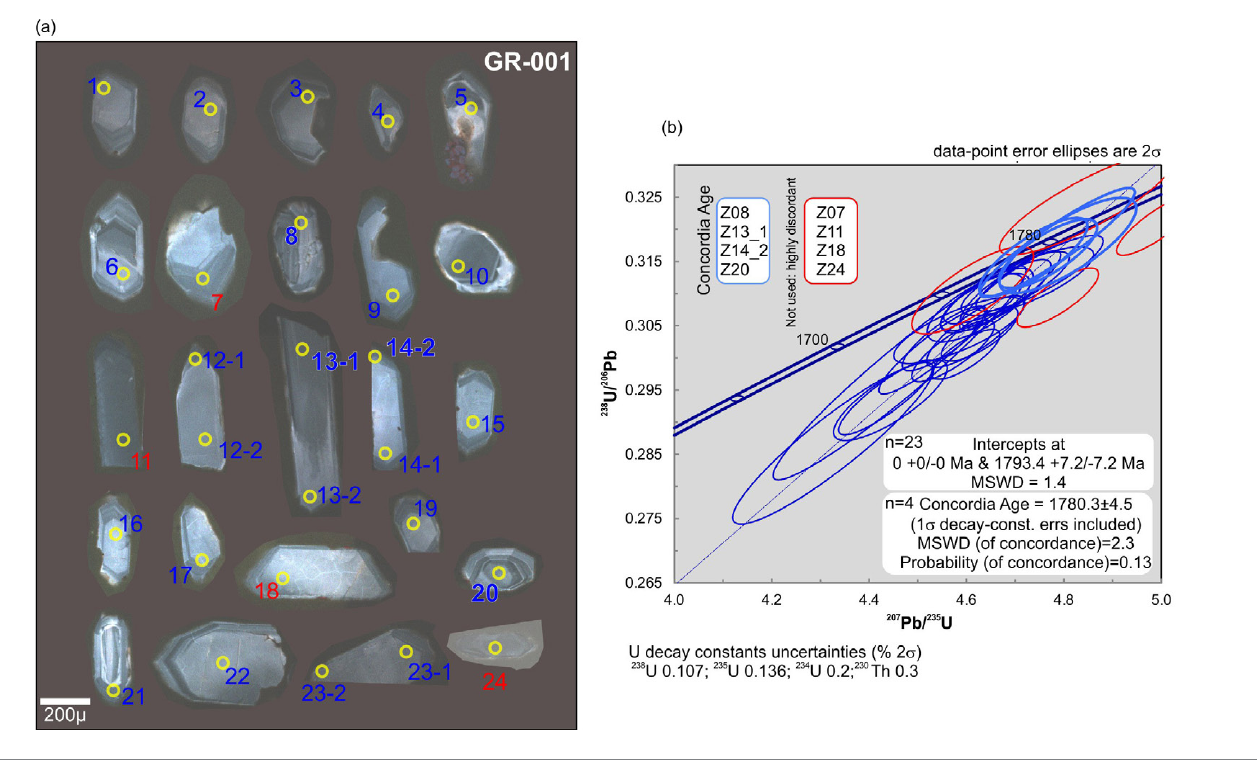
FIGURE 9 - (a) Cathodoluminescence image of zircons of a microgranite from the Paranaíta Intrusive Suite (sample GR-001) showing morphological features and location of pits; (b) U-Pb upper intercept age in the concordia diagram and the 207 Pb/ 206 Pb age of the two crystals aging around 1840 Ma. The blue color represent the spots results used in the upper intercept calculation, conversely, the red color represent those not used.